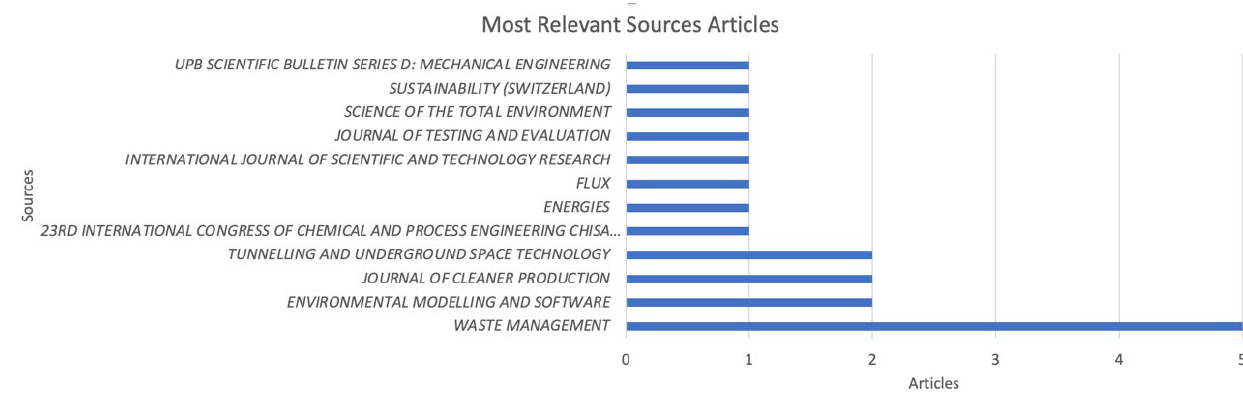
Figure 4. Most relevant sources using R-studio software and bibliometrix library of the automated waste collection system (AWCS) scientific literature found in Scopus.